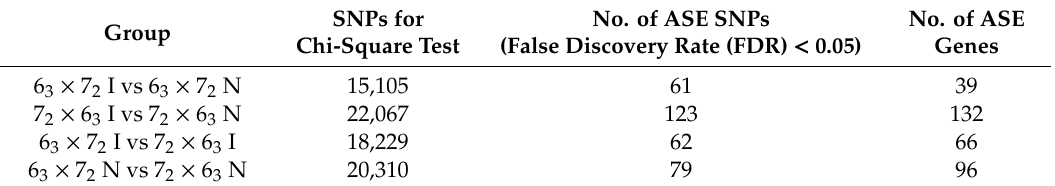
Table 3. Number of ASE SNPs.